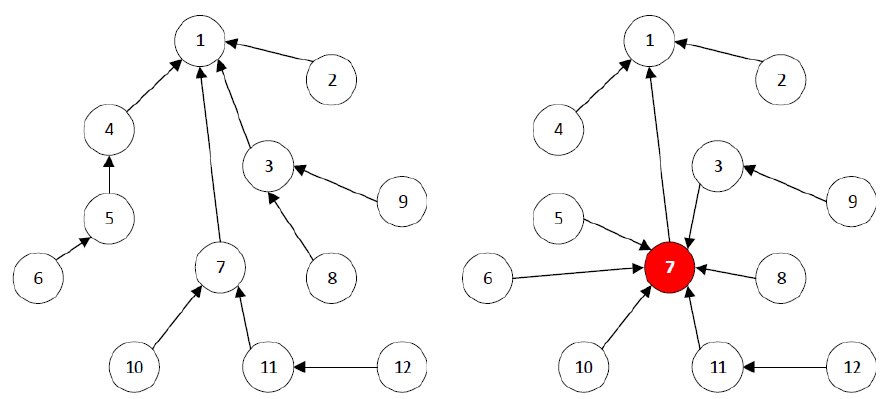
Figure 2. Normal Topology ( left side) and Decreased Rank Attack ( right side) [38]. Furthermore, A malicious node broadcasting a lower rank (decreased Rank attack), causes some DODAG’s portion to link to the root through the attacking node and also enables it to eavesdrop on that network traffic-forwarding segment. RPL can be targeted